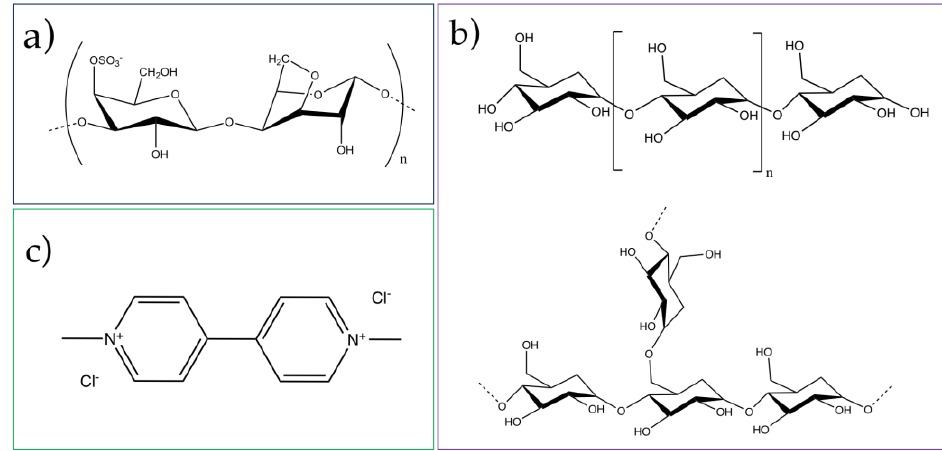
Figure 1. Structure of ( a ) κ-carrageenan; ( b ) starch, which contains ( top ) amylose (linear, 20 %); ( bottom ) amylopectin (branched, 80%) linked by glycosidic bonds and ( c ) paraquat.